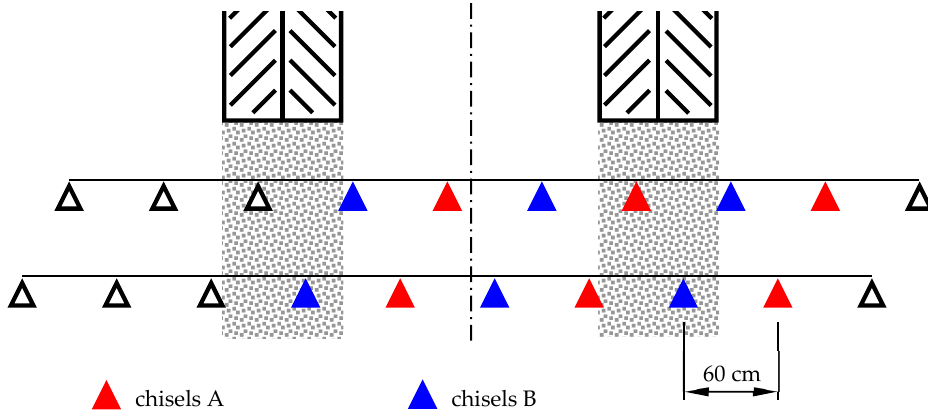
Figure 3. Distribution of tested elements on beams in a cultivation–sowing aggregate.